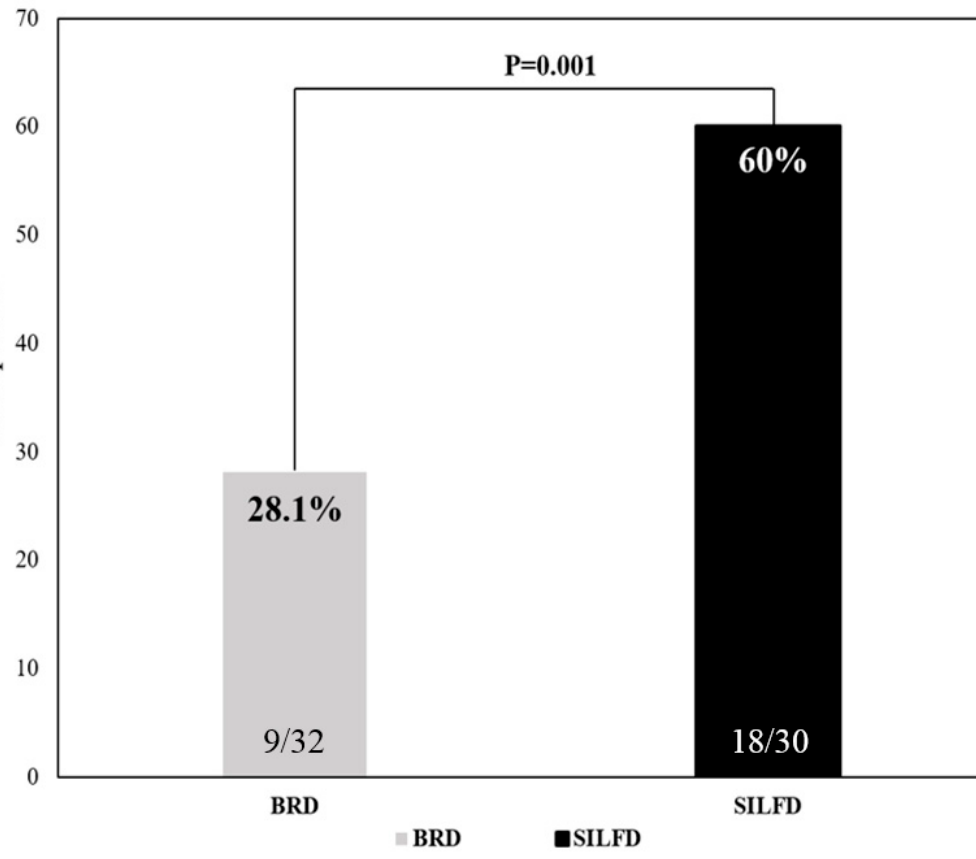
Figure 2. Responder rate comparison between structural individual low-FODMAPs diet advice (SILFD) and brief advice on a commonly recommended diet (BRD) for IBS patients.